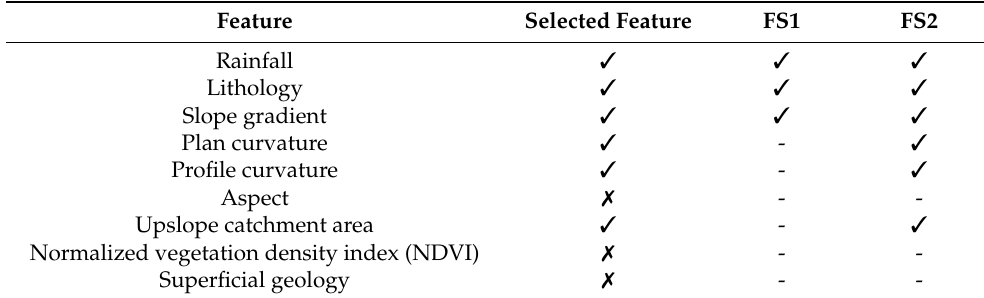
Table 3. Summary of potential features